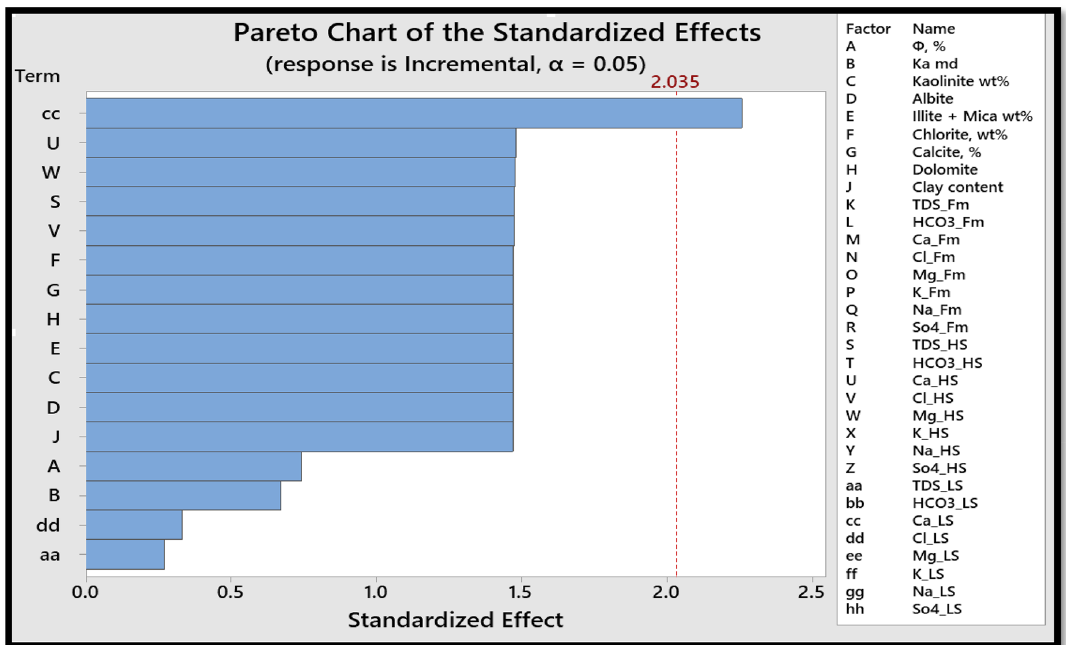
Fig. 9 Pareto chart using the complete dataset of the secondary